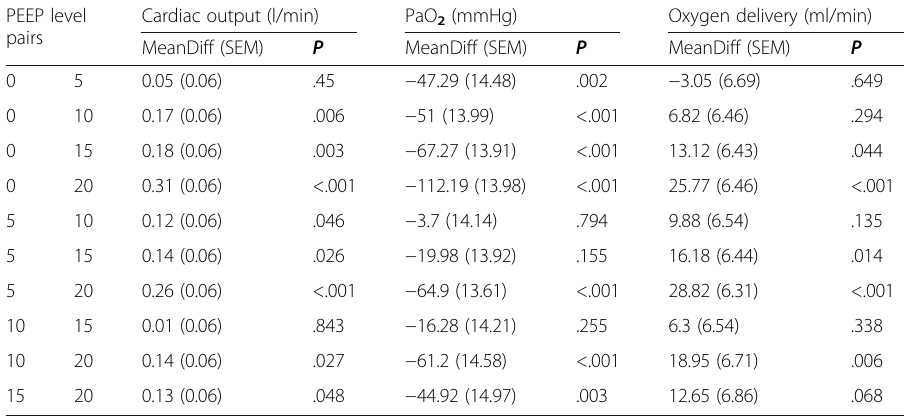
Table 3 Pairwise comparisons of main outcomes across positive end-expiratory pressure levels